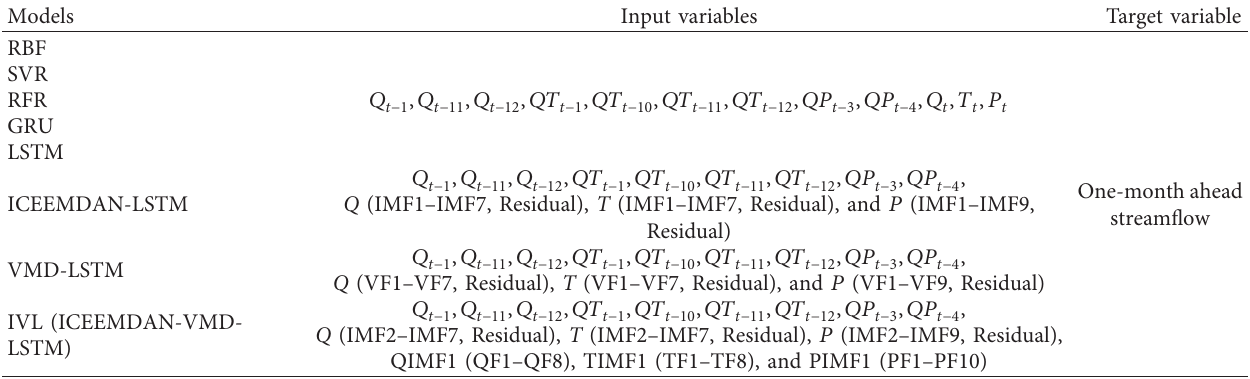
Table 1: Selection of the input variables for different models.